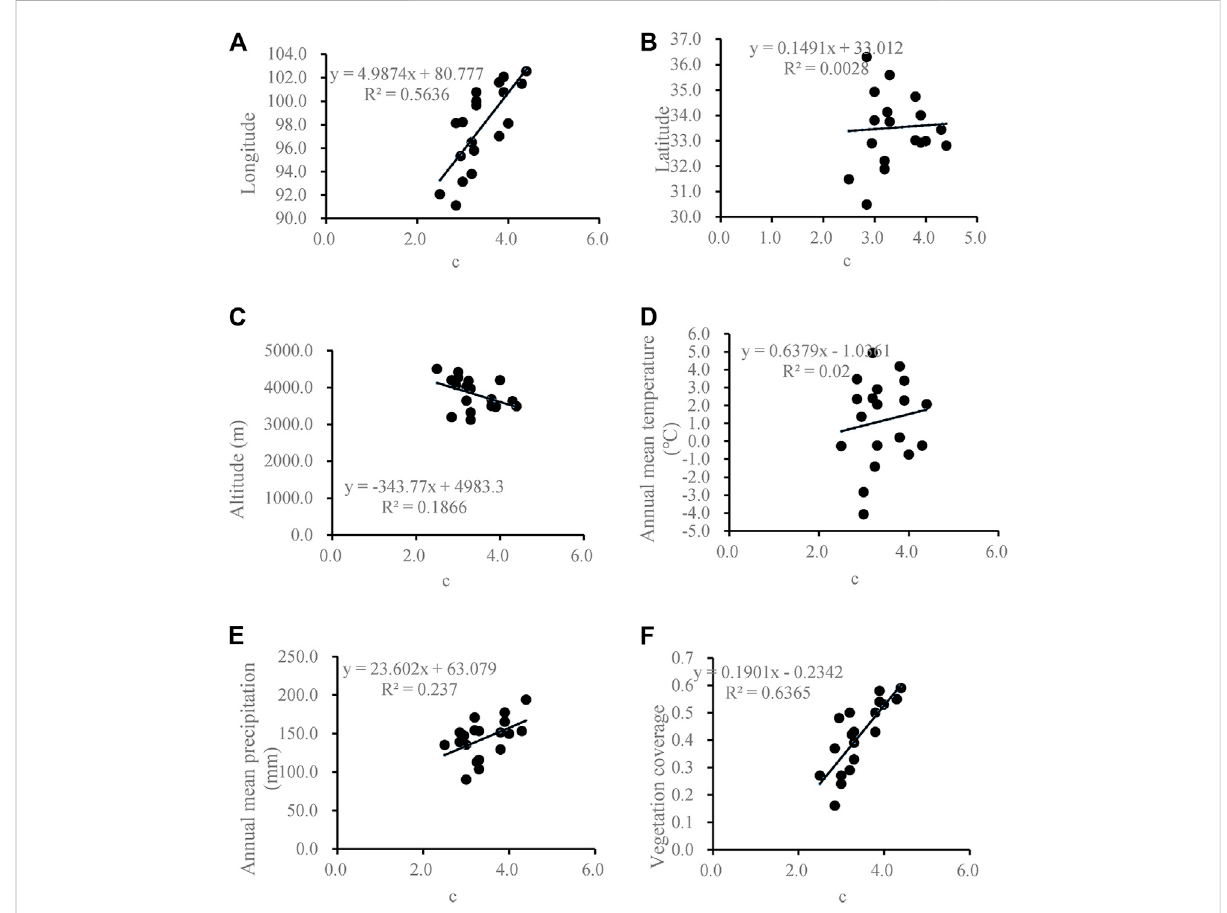
FIGURE 6 Correlation between model parameter and (A) longitude, (B) latitude, (C) altitude, (D) annual mean temperature, (E) annual mean precipitation, (F) vegetation